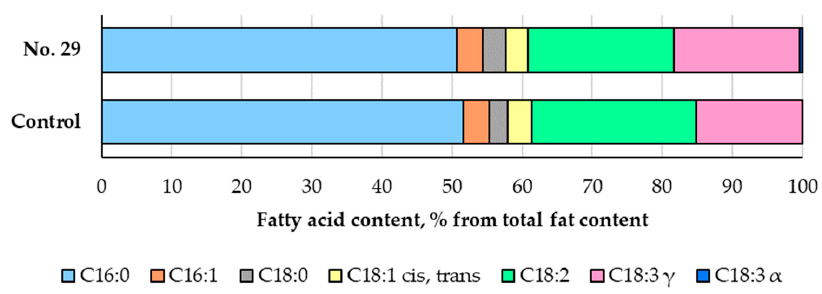
Figure 4. Fatty acid (FA) profile in the Spirulina samples (Control—Spirulina powder and water mixture, 1:2 w / w ; No. 29—Spirulina samples fermented for 24 h with Pediococcus acidilactici, strain No. 29; C16:0—palmitic acid; C16:1—palmitoleic acid; C18:0—stearic acid; C18:1 cis- and trans -9-oleic acid; C18:2—linoleic acid; C18:3 γ —gamma-linolenic acid; C18:3 α —alfa linolenic acid. Data are represented as means (n = 6) ± standard error. a–b mean values denoted with different letters indicate significantly different values between the samples ( p ≤